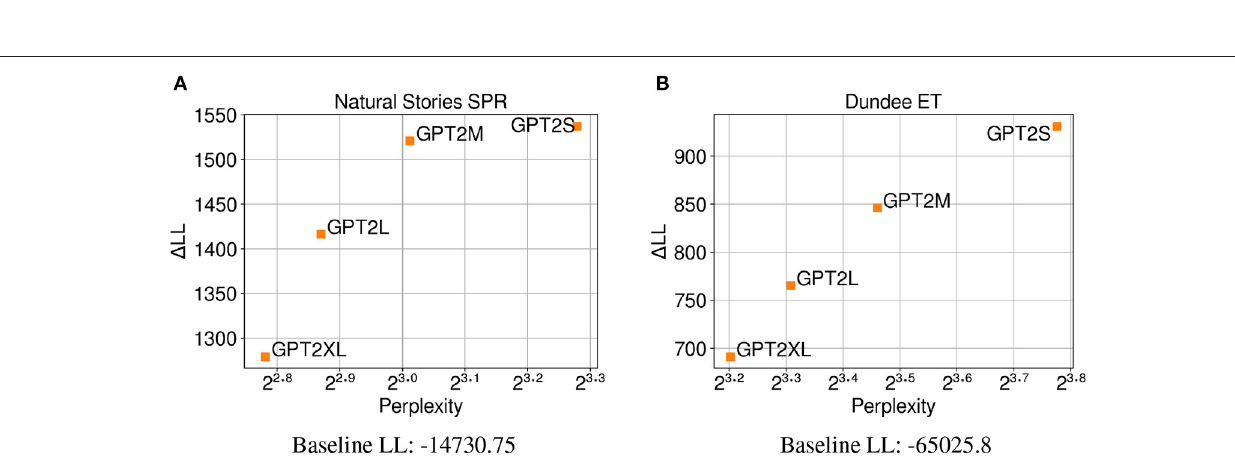
FIGURE 5 | Perplexity measures from each model, and improvements in CDR model log-likelihood from including each surprisal estimate on (A) Natural Stories self-paced reading data and (B) Dundee eye-tracking data. The difference in by-item squared error between the Structural and GPT2XL models is significant at p < 0.05 level for both datasets.